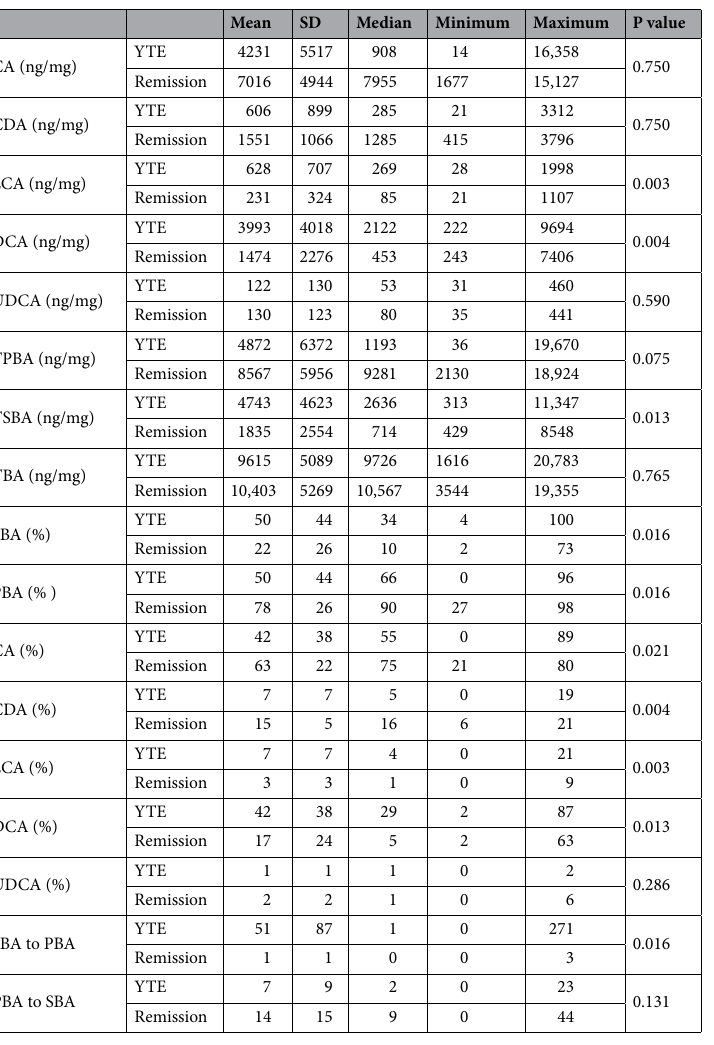
Table 6. Summary statistics of bile acid concentrations in YTE dogs before and after treatment. CA, cholic acid; CDA, chenodeoxycholic acid; LCA, lithocholic acid; DCA, deoxycholic acid; UDCA, ursodeoxycholic acid; TPBA, total primary bile acids; TSBA, total secondary bile acids; SBA to PBA; ratio of secondary to primary bile acids; PBA to SBA, ratio of primary to secondary bile acids; YTE, Yorkshire Terrier enteropathy; SD, standard